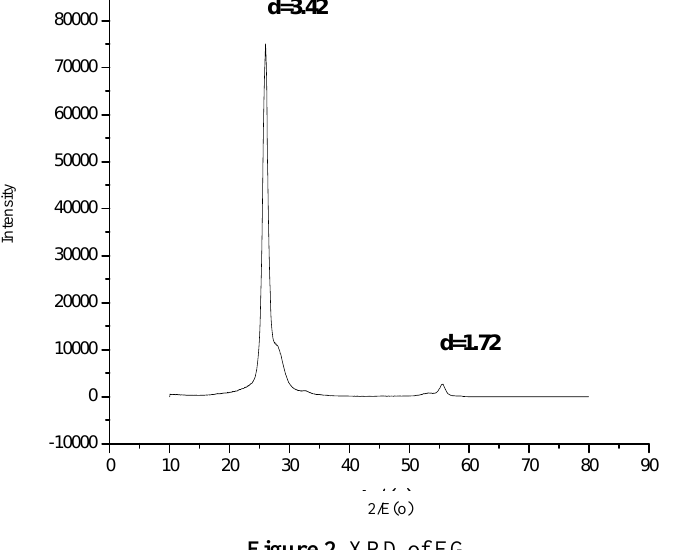
Figure 2. XRD of